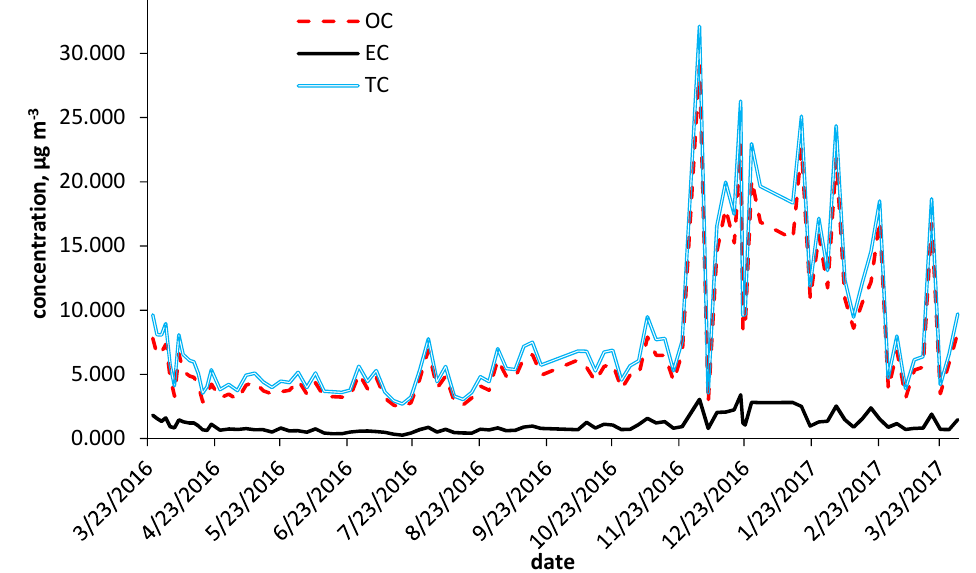
Figure 4. Seasonal variation of EC, OC, and TC from March 2016 to April 2017.